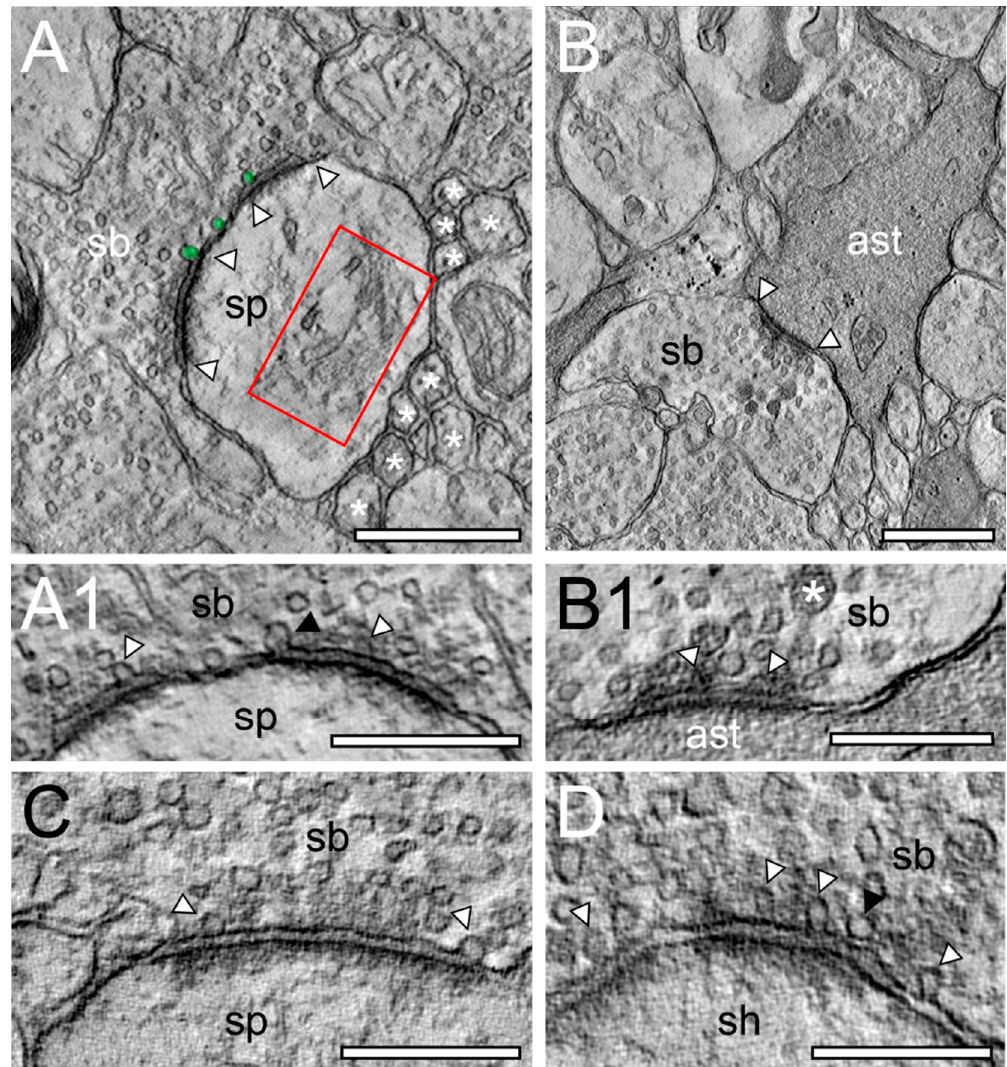
Figure 6. EM tomography of synaptic complexes and active zone with “docked” SVs. ( A ), Single EM micrograph of a tomographic TILT series through a synaptic complex between a spine (sp) and a synaptic bouton (sb) in L6a of the human TLN. The framed area indicates a large spine apparatus and arrowheads indicate the AZ. “Docked” vesicles are highlighted in transparent green. Note the cluster unmyelinated at the synaptic complex. ( A1 ), High magnification of the AZ shown in A. The synaptic bouton (sb) is on top the spine (sp) at the bottom of the images. Here, the “docked” SVs (arrowheads) are clearly visible. Note the omega-shaped SV (black arrowhead) indicating the already occurred release of a quantum of neurotransmitter. ( B ), Synaptic bouton (sb) establishing a contact (arrowheads) with an astrocytic process (ast) identified by its darker appearance in L6b of the human TLN. ( B1 ), Higher magnification of the AZ shown in B. Here, two SVs are already fused with the presynaptic membrane as marked by arrowheads. Note also the large dense core vesicle (asterisk). ( C ), Large macular, non-perforated AZ between a spine (sp) and a synaptic bouton (sb) with two ‘docked vesicles’ in L5 of the human TLN. ( D ), Large non-perforated AZ at a synaptic complex between a dendritic shaft (sh) and a synaptic bouton (sb) with four “docked” SV (arrowheads), two with an omega-shaped appearance. Note the SV (black arrowhead) close, but not fused with the presynaptic density. Scale bar in ( A ), ( B ) 0.5 µm and in ( A1 ), ( B1 ), ( C ), ( D ) 0.25 µm.